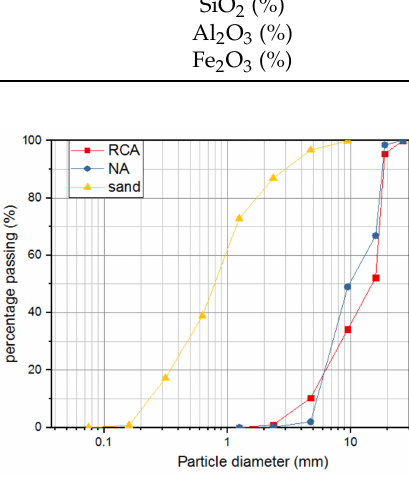
Figure 1. Grading curve of aggregates. Table 2. Properties of the NCA and RCA.